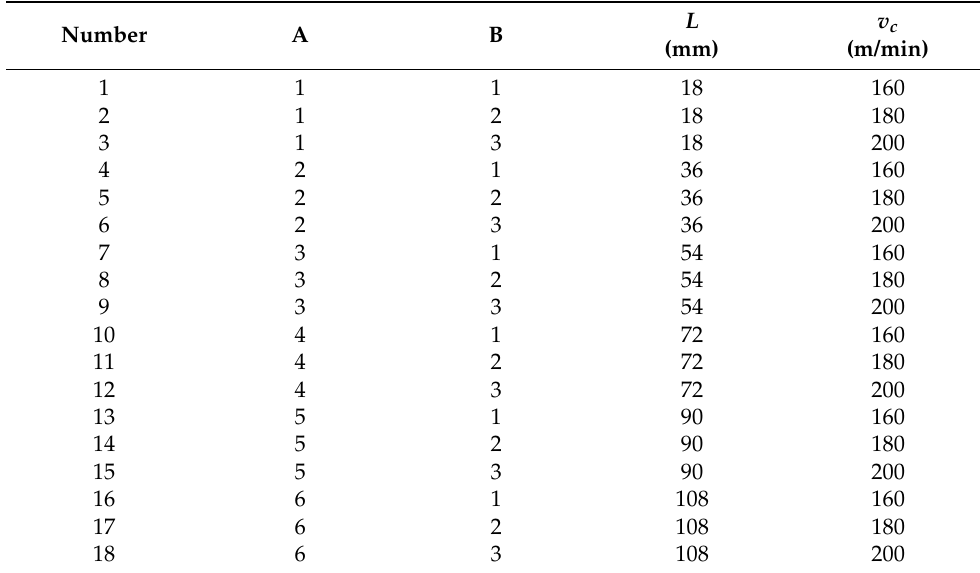
Table 4. Research plan based on the Taguchi